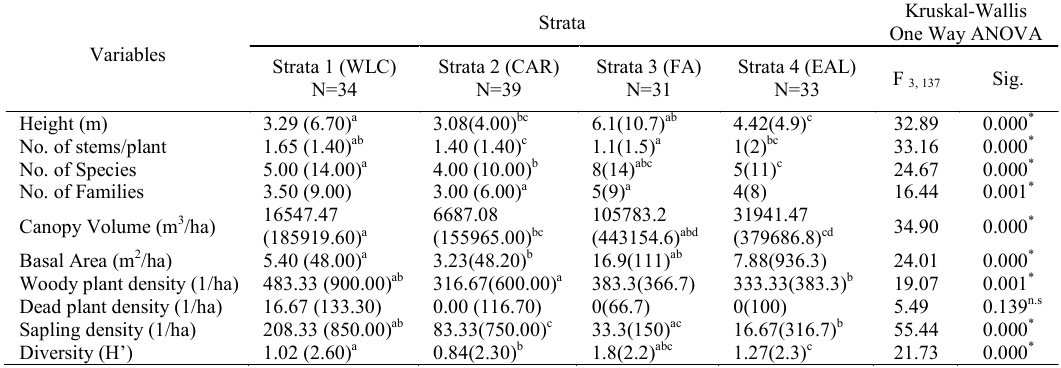
Table 2: Attributes of vegetation structure and composition across selected soil strata in Mapungubwe Cultural Landscape